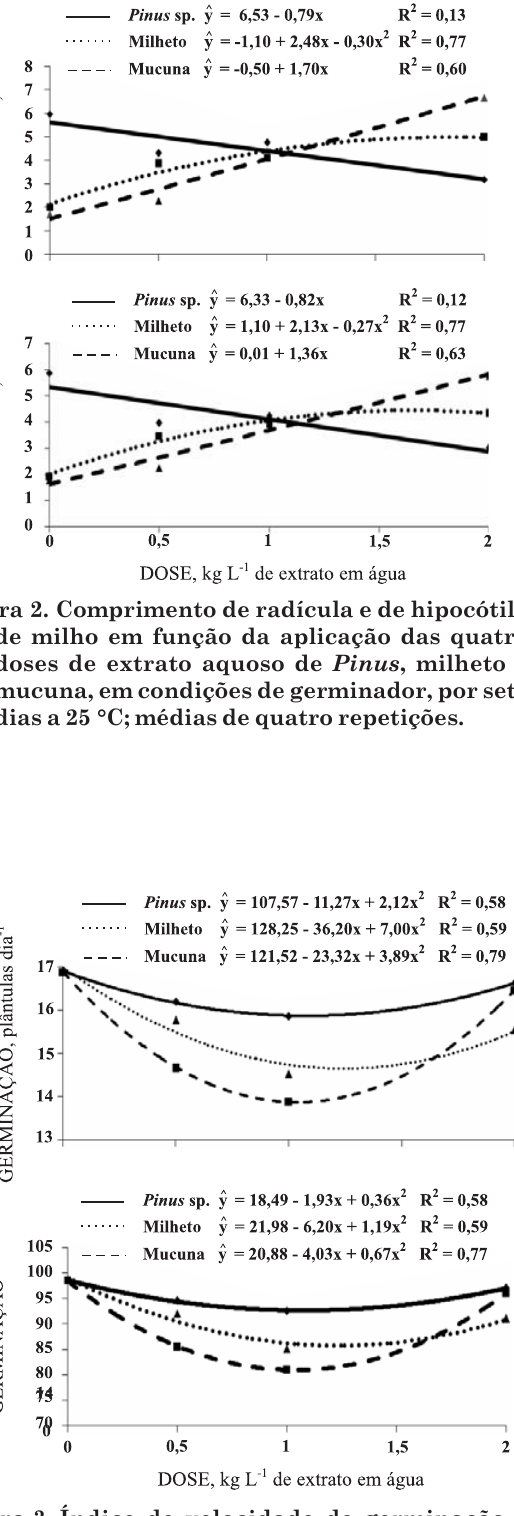
Figura 4. Número de esporos de fungos micorrízicos arbusculares em cultura de soja em função da aplicação de quatro doses de extrato aquoso de Pinus , milheto e mucuna, em condições de casa de vegetação, por 45 dias; médias de quatro